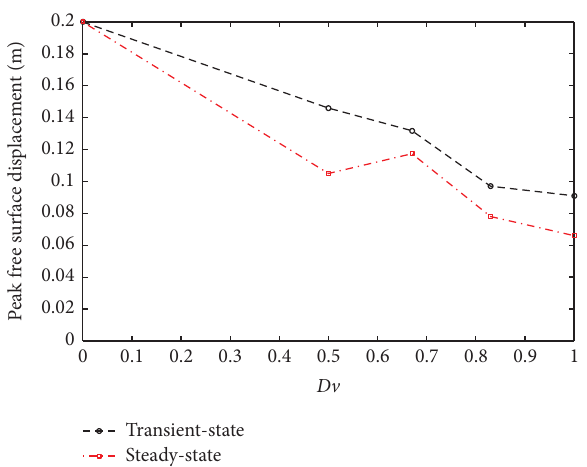
Figure 8: The peak free surface displacement response of coupled sloshing for different vertical baffle